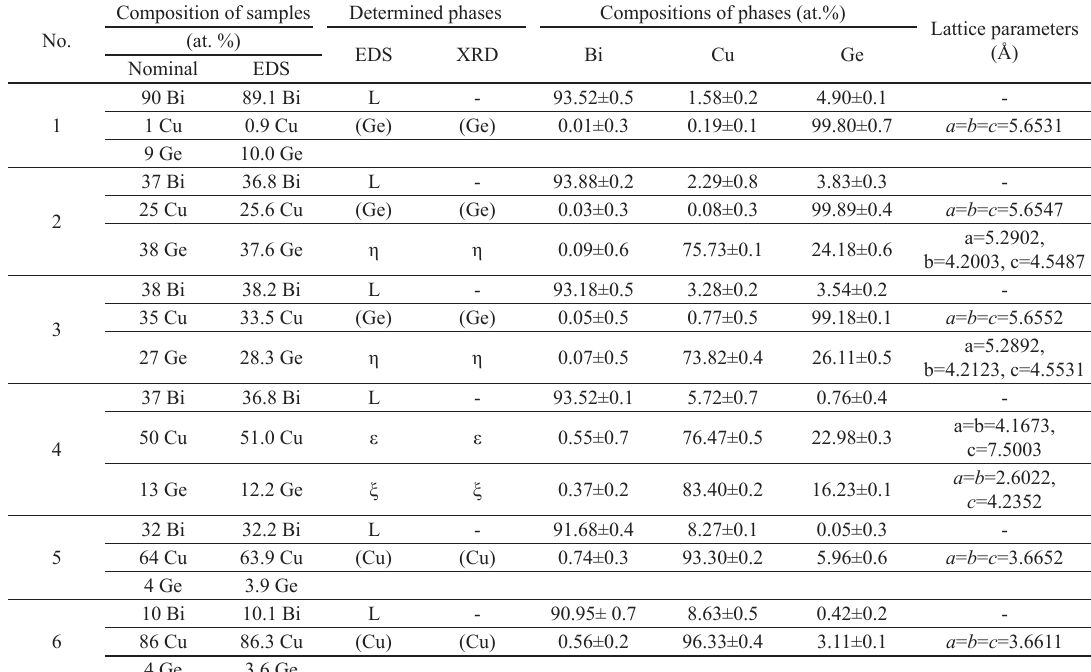
Table 2. Combined results of SEM-EDS and XRD analyzes of the selected Bi-Cu-Ge alloys annealed at T=600 °C. Composition of No.